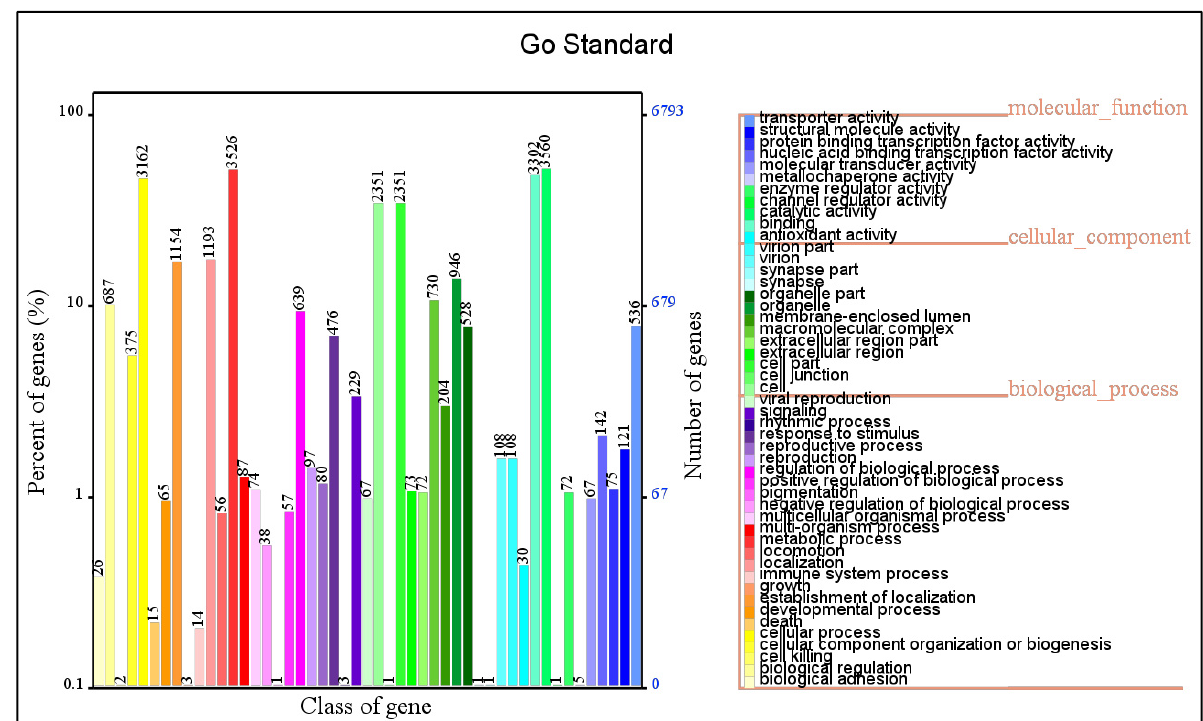
Figure 1. GO functional annotation of the A. rasikravindrae genome. In the (GO) annotation, the protein-coding sequences of the fungus A. rasikravindrae genome are divided into three major categories, (MF), (CC), and (Bprocess); different colors represent 49 sub-classes from these three major categories. Although in this figure the X-axis represents the class of genes and Y-axis represents the percent of genes (%), while the Z-axis represents the number of genes with a scale up to 6793.